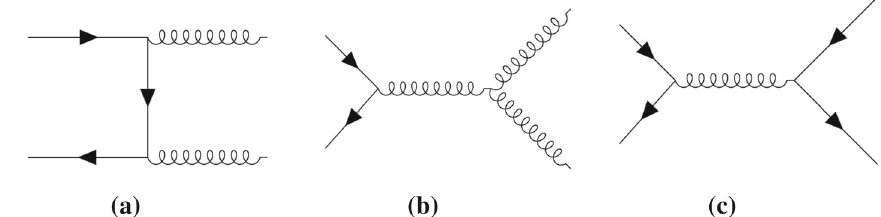
Fig. 1 The order α 2